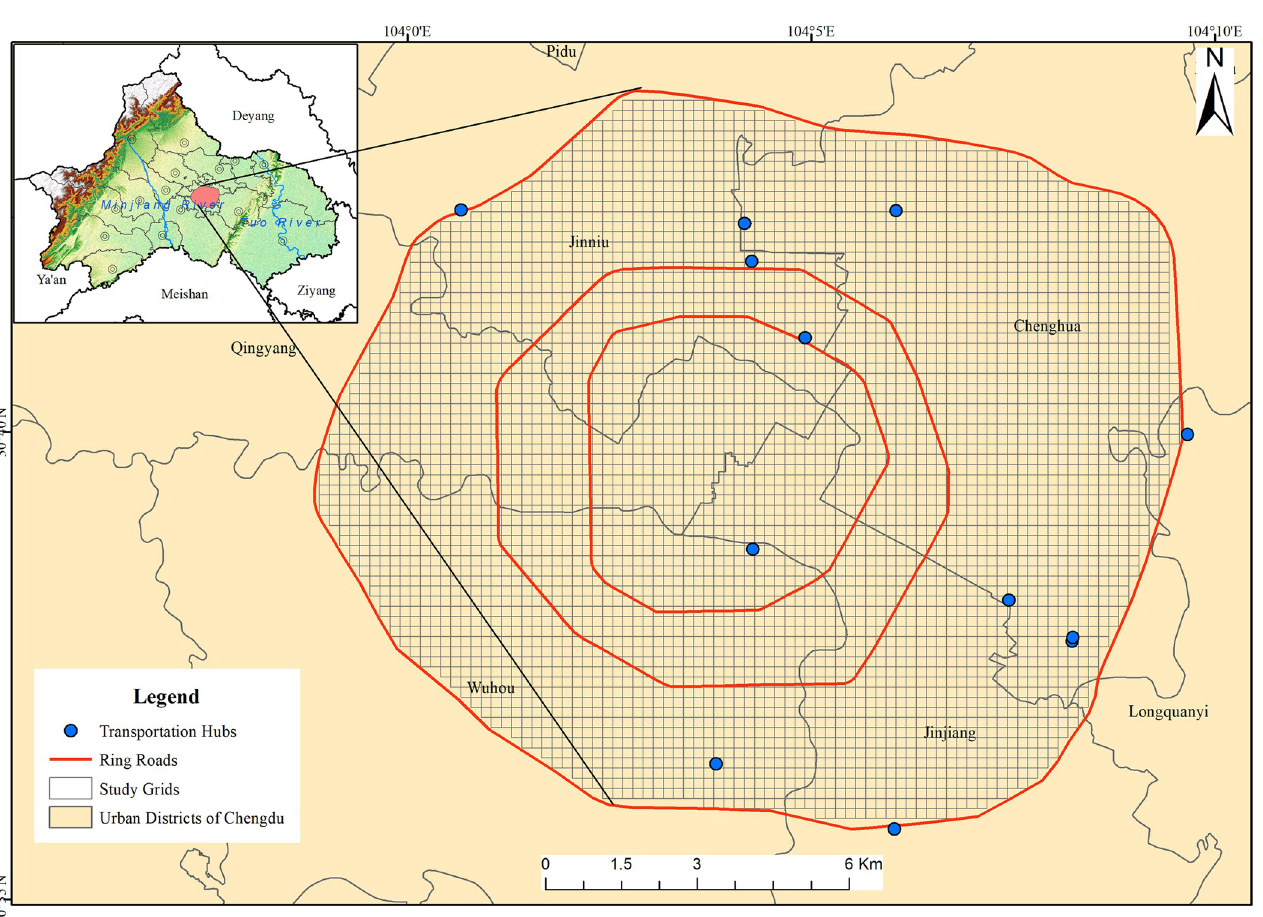
Fig 1. Study area within third ring road in Chengdu and grid division.